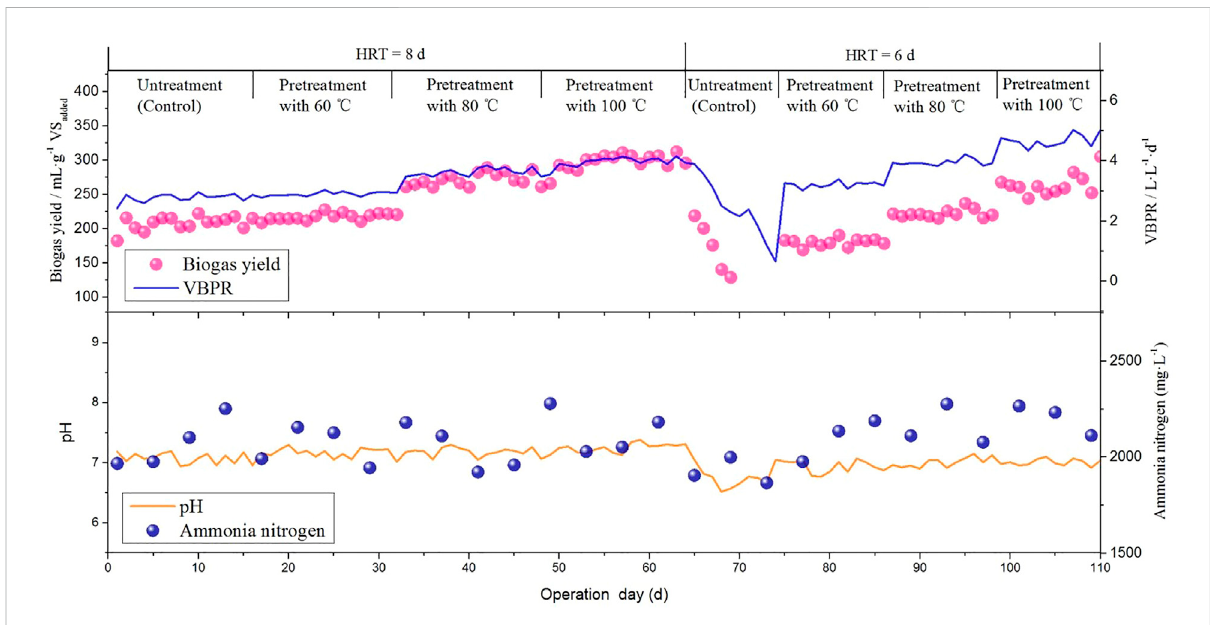
FIGURE 4 Changes of daily biogas production, pH and ammonia nitrogen in semi-continuous AD